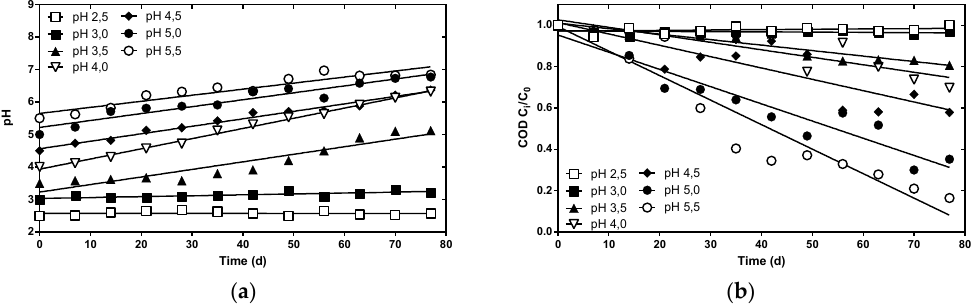
Figure 2. Sulfate Reducing Bacteria (SRB) acid tolerance. ( a ) Variation of pH and chemical oxygen demand (COD) consumption ( b ) in anaerobic batch reactors. The COD consumption is expressed as the relative concentration (Ci/C0) related to the initial COD concentration of the culture medium (Ci = concentration at time i, C 0 = initial COD concentration). C 0 in the aqueous phase of all reactors was 1040 ± 5 mg · L − 1 . Initial SO 42 − = 3067.9 mg · L − 1 , Fe = 0.8 mg · L − 1 . A linear regression was fitted to the data in different pH conditions.